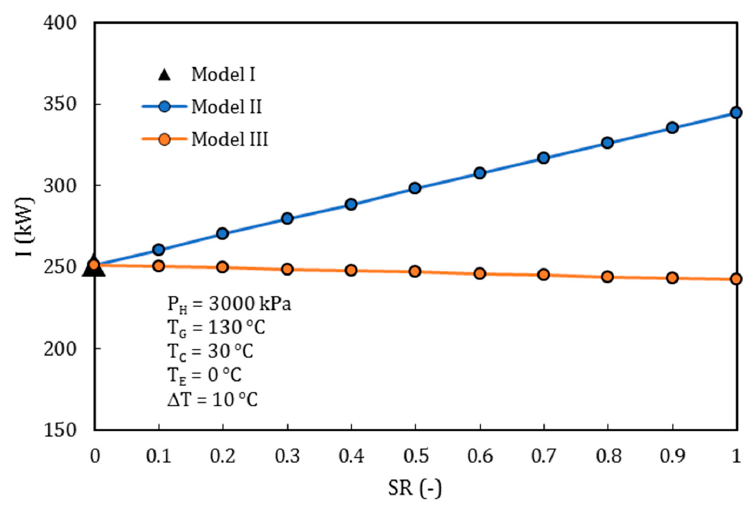
Figure 17. Comparison of the η EX as a function of SR for the three models.